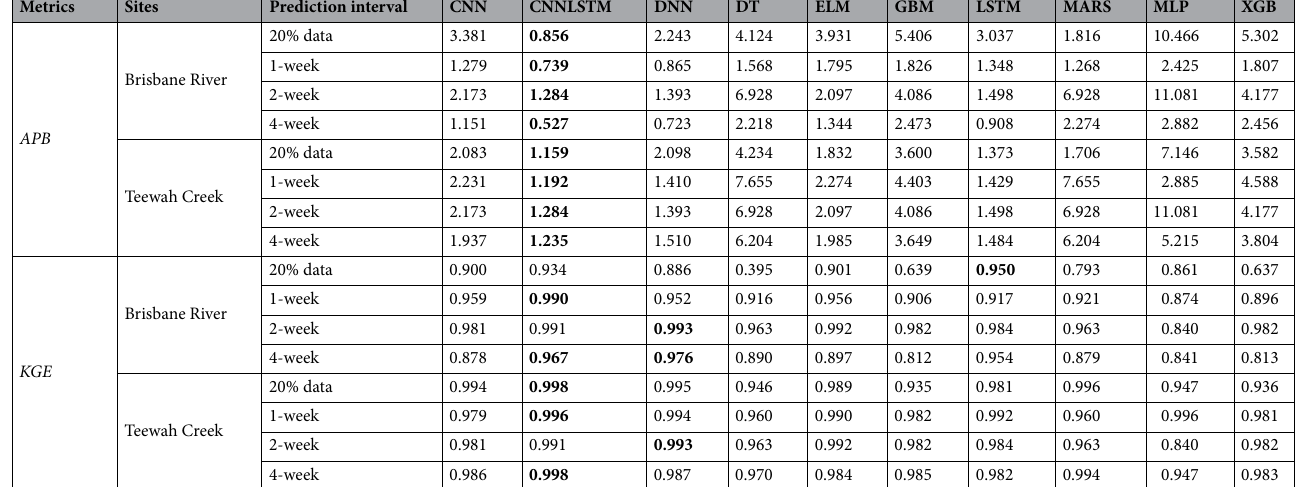
Table 7. Comparison of CNNLSTM model performances with the comparative counterpart models: Convolutional Neural Network (CNN) and Long Short Term Memory Network (LSTM) as well as the Deep